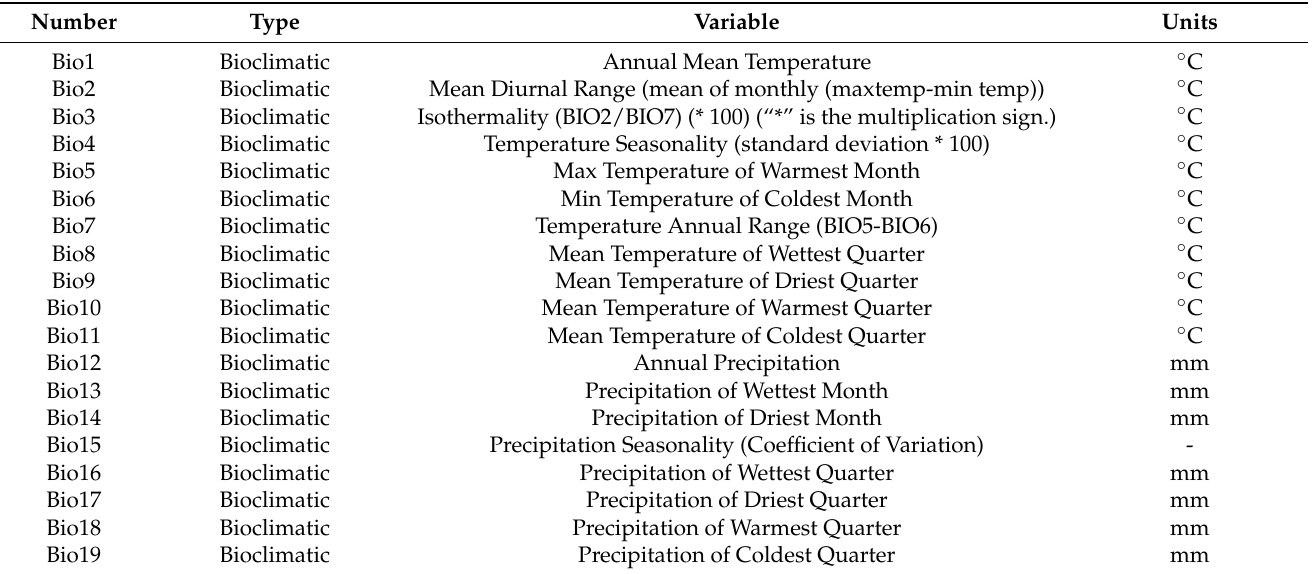
Table 2. Nineteen global climate